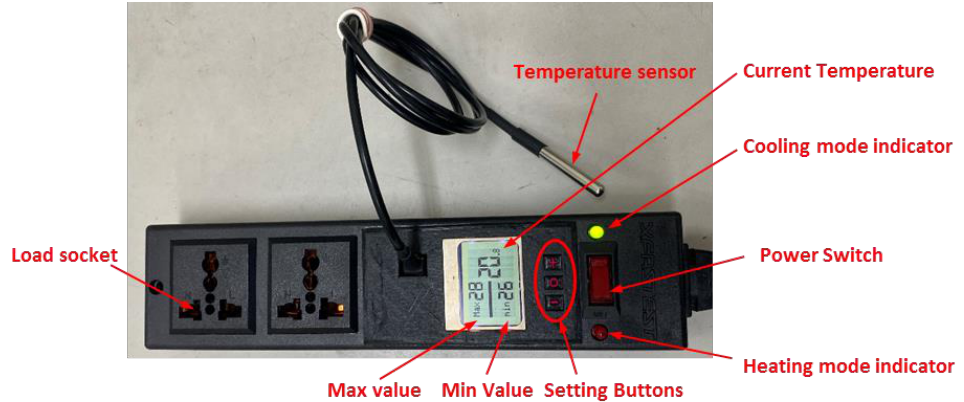
Figure 5. Photograph of the hardware prototype of the proposed extender.